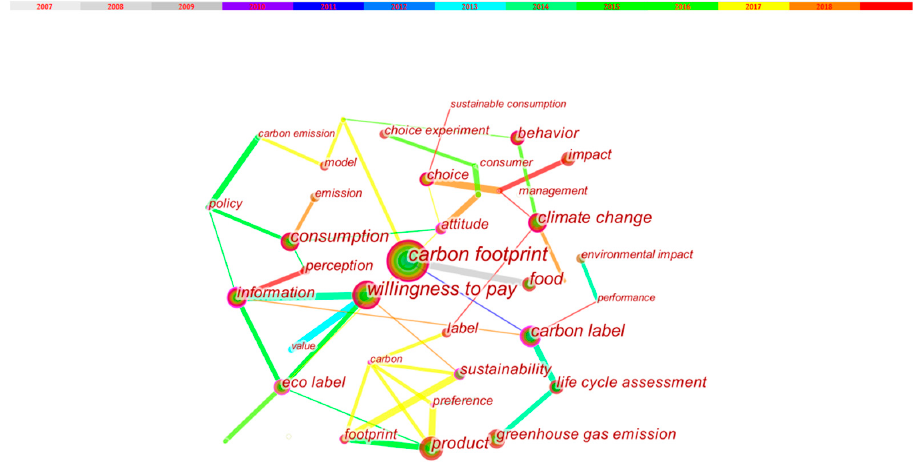
Figure 5. Keywords co-occurrence network.